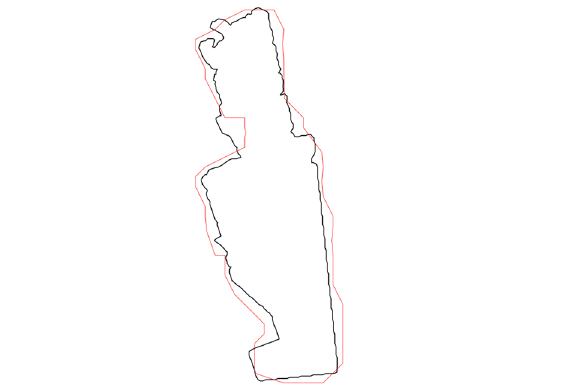
Figure 1. Outline of a viewshed computed at 0.25 m [black] and at 2 m [red]